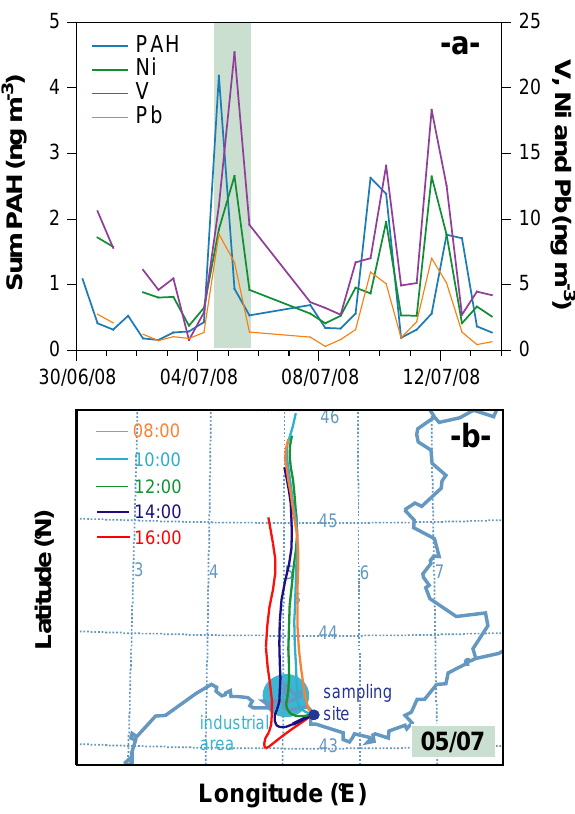
Fig. 3 Fig. 3. (a) Time series of the industrial emission markers: V, Ni, Pb and sum of heavy PAH (benzo[b,k]fluoranthene, benzo[e]pyrene, Indeno[1,2,3-cd]pyrene and Benzo-ghi-perylene). (b) HYSPLIT air mass backward trajectory (Rolph, 2010) illustrating the overall air masses circulation occurring during a typical industrial events (5 July 2008 08:00–16:00). Backward trajectories are confirmed by both MM5 modelling and local winds